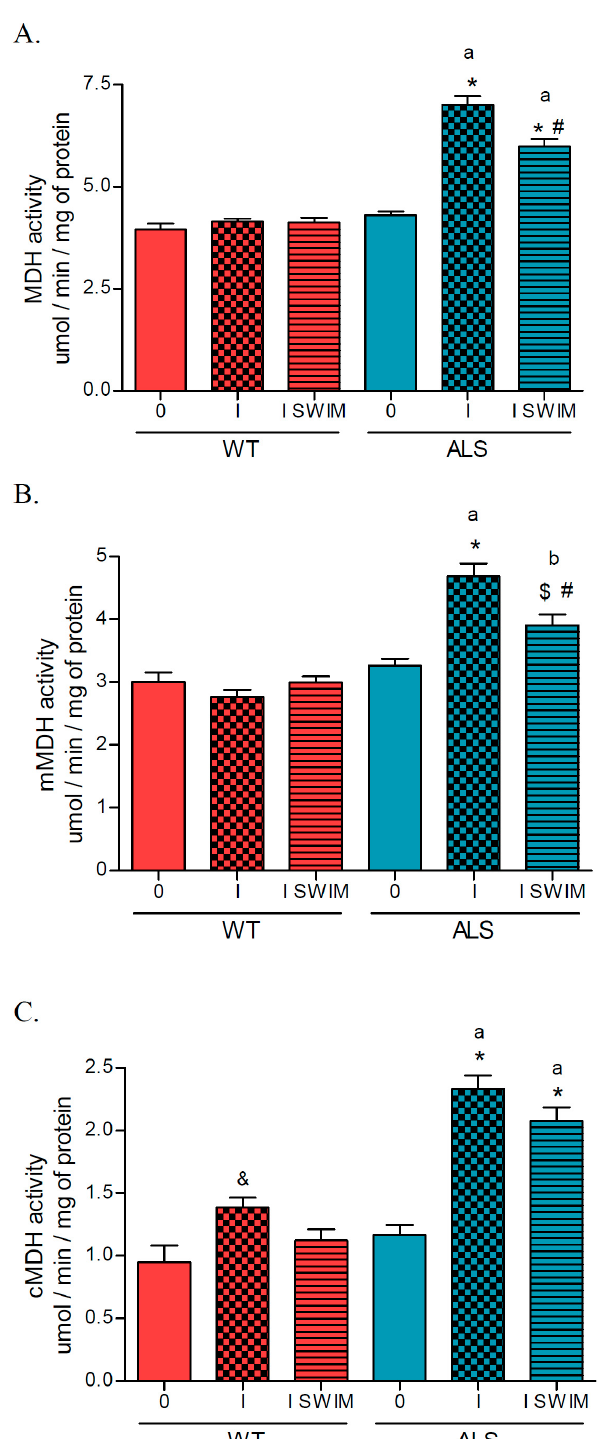
Figure 3. Malate dehydrogenase activity in skeletal muscle of ALS and WT mice. Total malate dehydrogenase (MDH) ( A ), mitochondrial malate dehydrogenase (mMDH) ( B ), and cytosolic malate dehydrogenase (cMDH) ( C ) were measured in skeletal muscle homogenates. There were significant differences between the groups: * p = 0.0001 vs. ALS 0, # p = 0.0054 vs. ALS I, $ p = 0.0357 vs. ALS 0, & p = 0.04 vs. WT 0; a p = 0.000, b p = 0.0009 between the indicated ALS and corresponding WT groups. The data are presented as the means ± SEM ( n = 8 in each group).